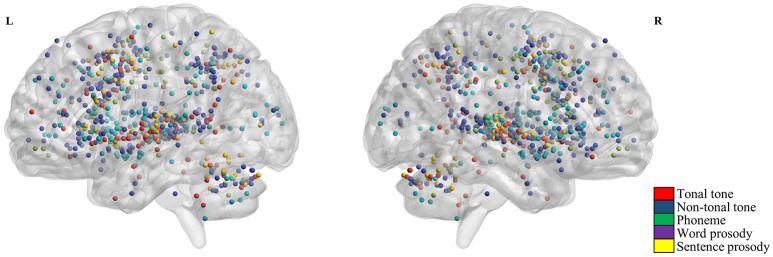
Activation foci from selected contrasts. Red, blue, green, violet, and yellow dots represent foci from tonal tone, non-tonal tone, phoneme, word prosody and sentence prosody, respectively. Across conditions, foci were widely distributed in bilateral temporal, frontal, parietal regions, and the cerebellum.